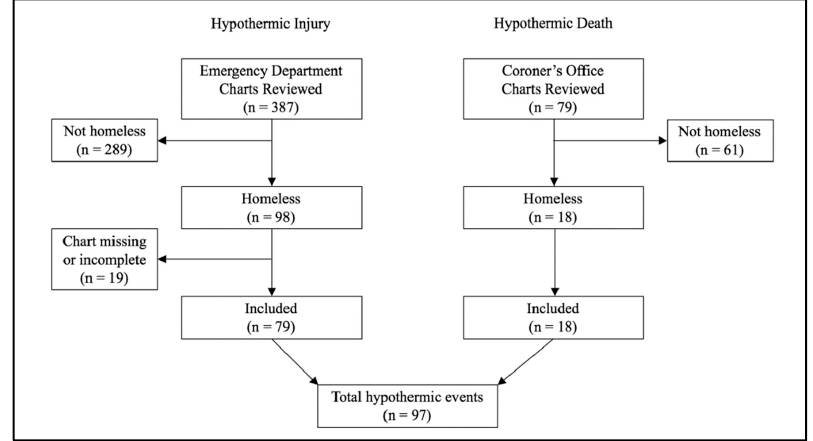
Figure 1. Flow chart describing the inclusion criteria for the hypothermic events identified from